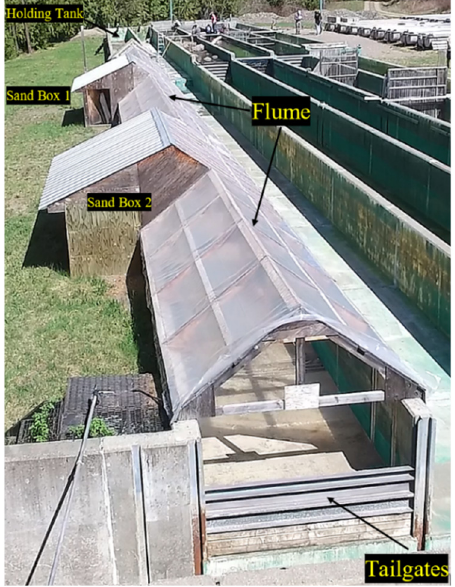
Figure 2. The view of the original site (experimental flume).